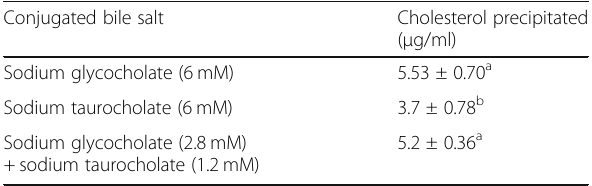
Table 5 Co-precipitation of cholesterol with deconjugated bile salt by Lactococcus lactic subsp. lactis